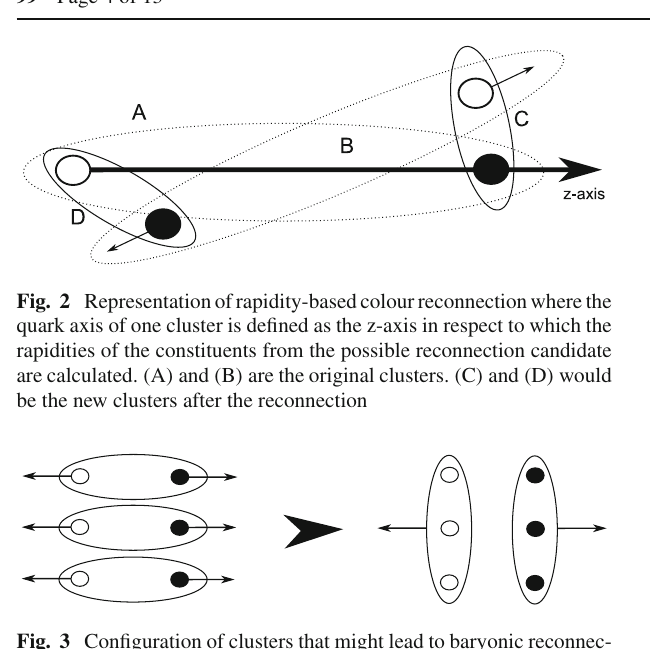
Fig. 3 Configuration of clusters that might lead to baryonic reconnec- tion. The small black arrows indicate the direction of the quarks. A reconnection is considered if all quarks move in the same direction and all anti-quarks move in the same direction